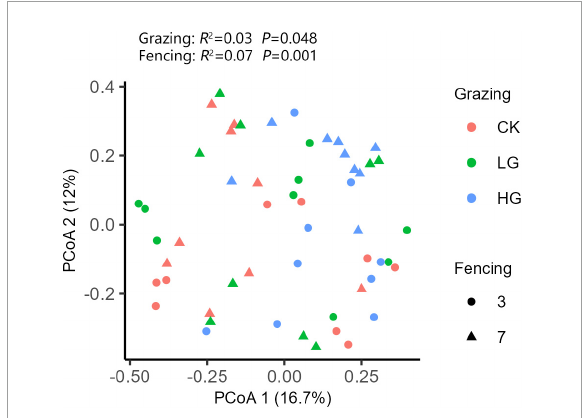
FIGURE2 Principal coordinate analysis (PCoA) of insect communities across two fencing periods and three grazing intensities. PCoA was generated by the Bray–Curtis dissimilarity